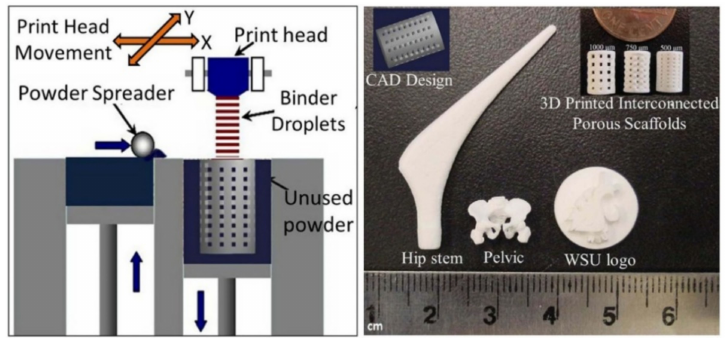
Figure 3. A schematic of 3D printing and some 3D-printed parts (fabricated at Washington State University) showing the versatility of 3D-printing technology for ceramic scaffolds fabrication with complex architectural features. Reprinted from Ref. [56] with